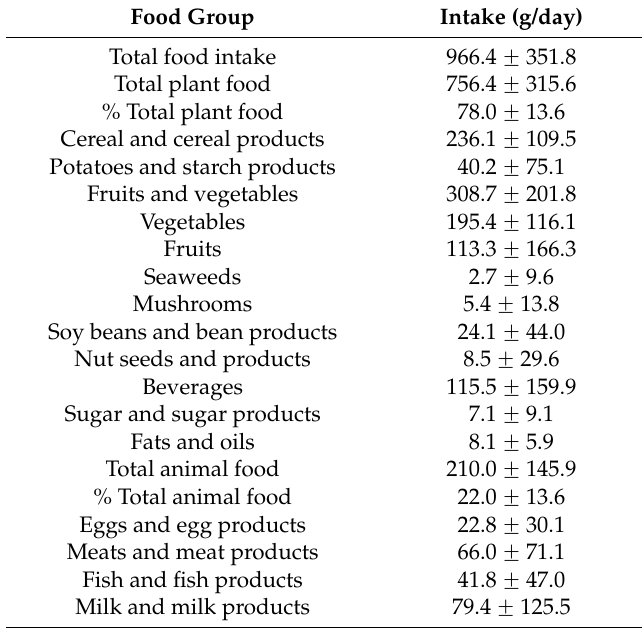
Table 3. Study population dietary intakes a ( n =